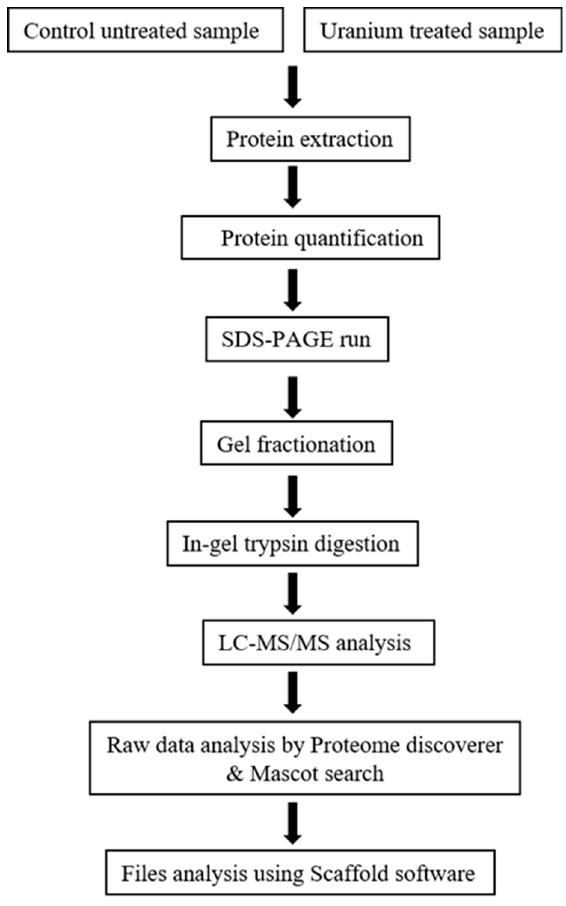
Figure 5. Shown is the proteomics workflow followed in this study.